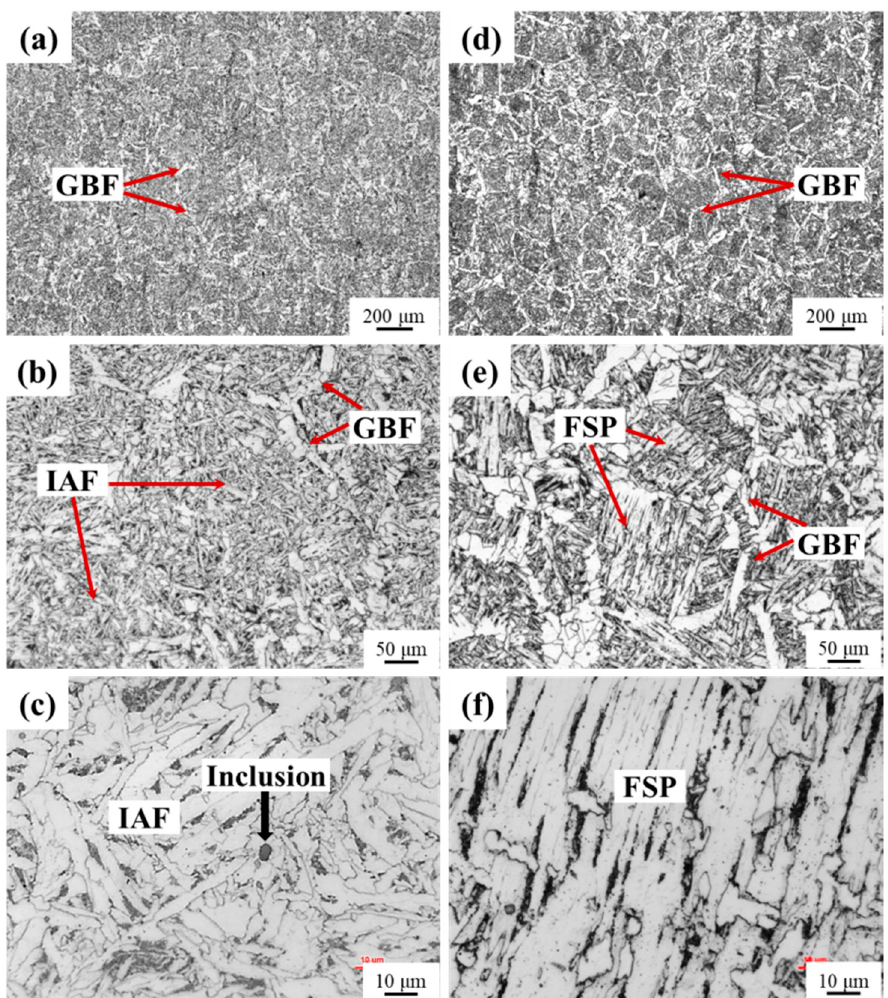
Figure 8. HAZ microstructures of experimental steels after high-heat-input welding with 400 kJ/cm. ( a – c ) 3Mg1Al; ( d – f ) 3Mg20Al. GBF, grain boundary ferrite; IAF, intragranular acicular ferrite; FSP, ferrite side plate.